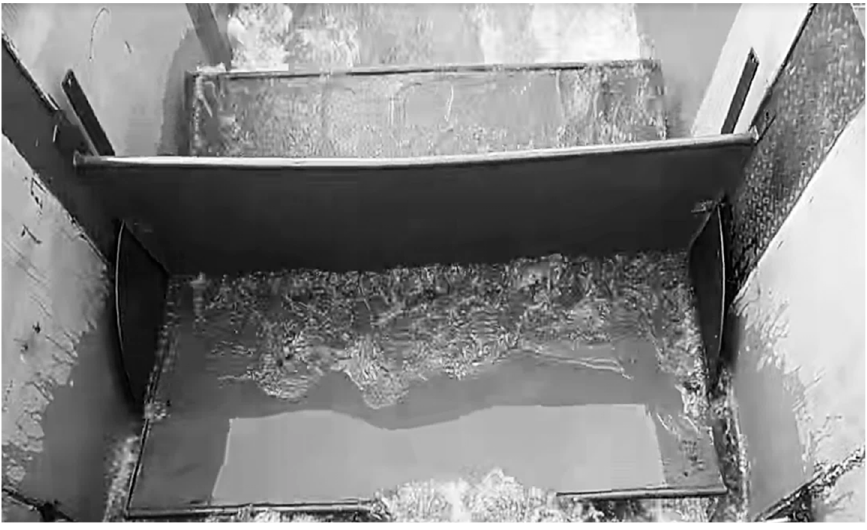
Figure 3. The five-blade water wheel model was used in experiments.